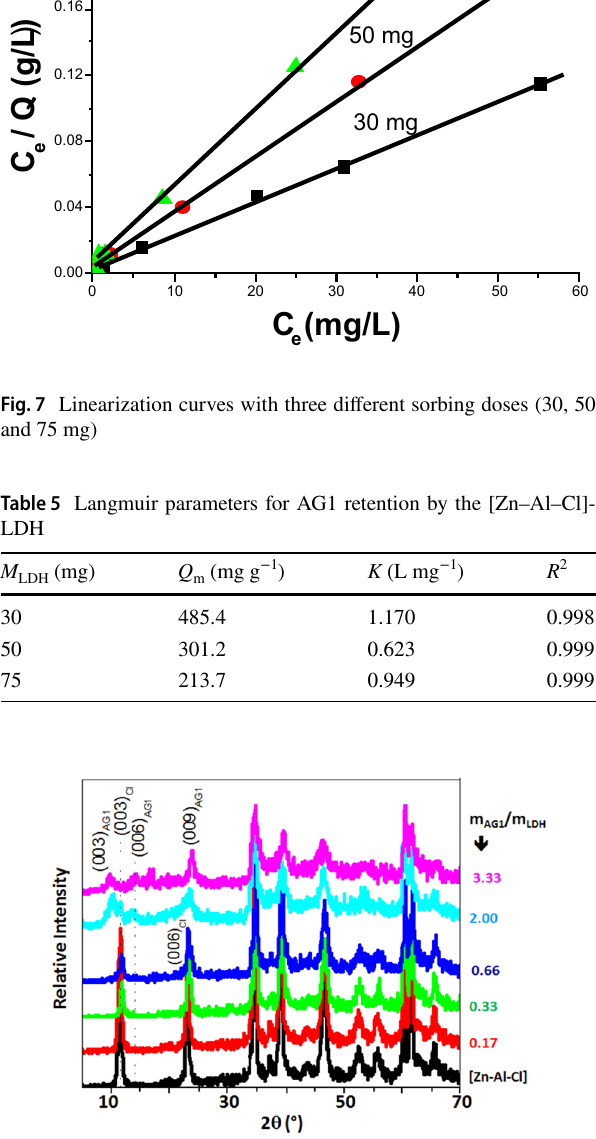
Fig. 8 XRD patterns of the phases obtained after retention of AG1 at different mass ratio